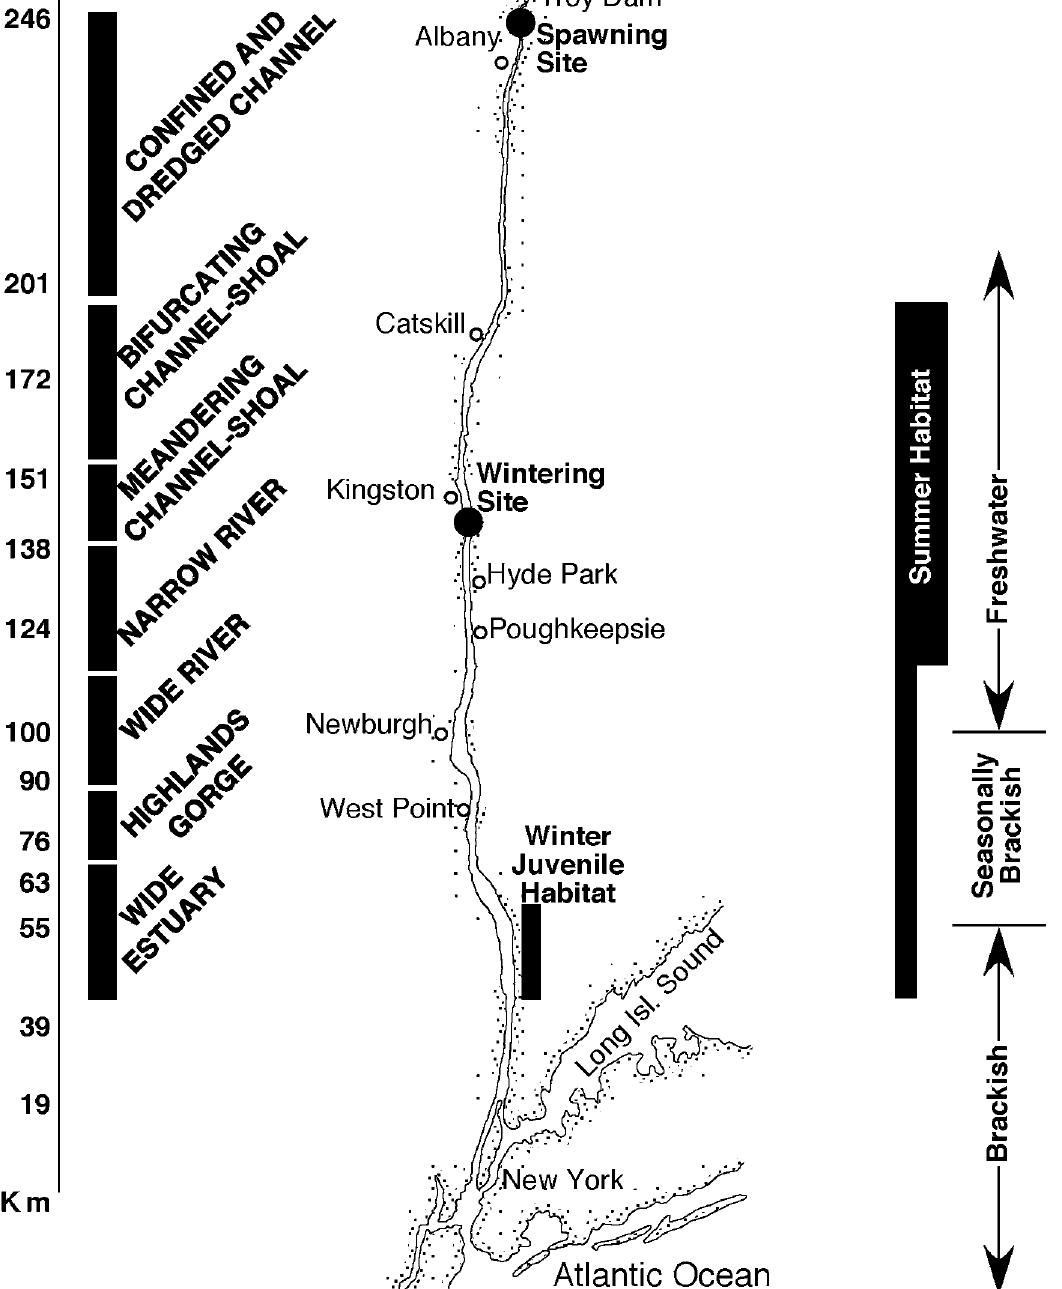
Figure 1. Map of the Hudson River estuary with key habitats used by shortnose sturgeon and the salinity zones in the system. Summer habitat, winter juvenile habitat, and salinity zones match horizontally on the figure with locations in the river. The width of the summer habitat designation corresponds with most and least heavily used sections of the river.